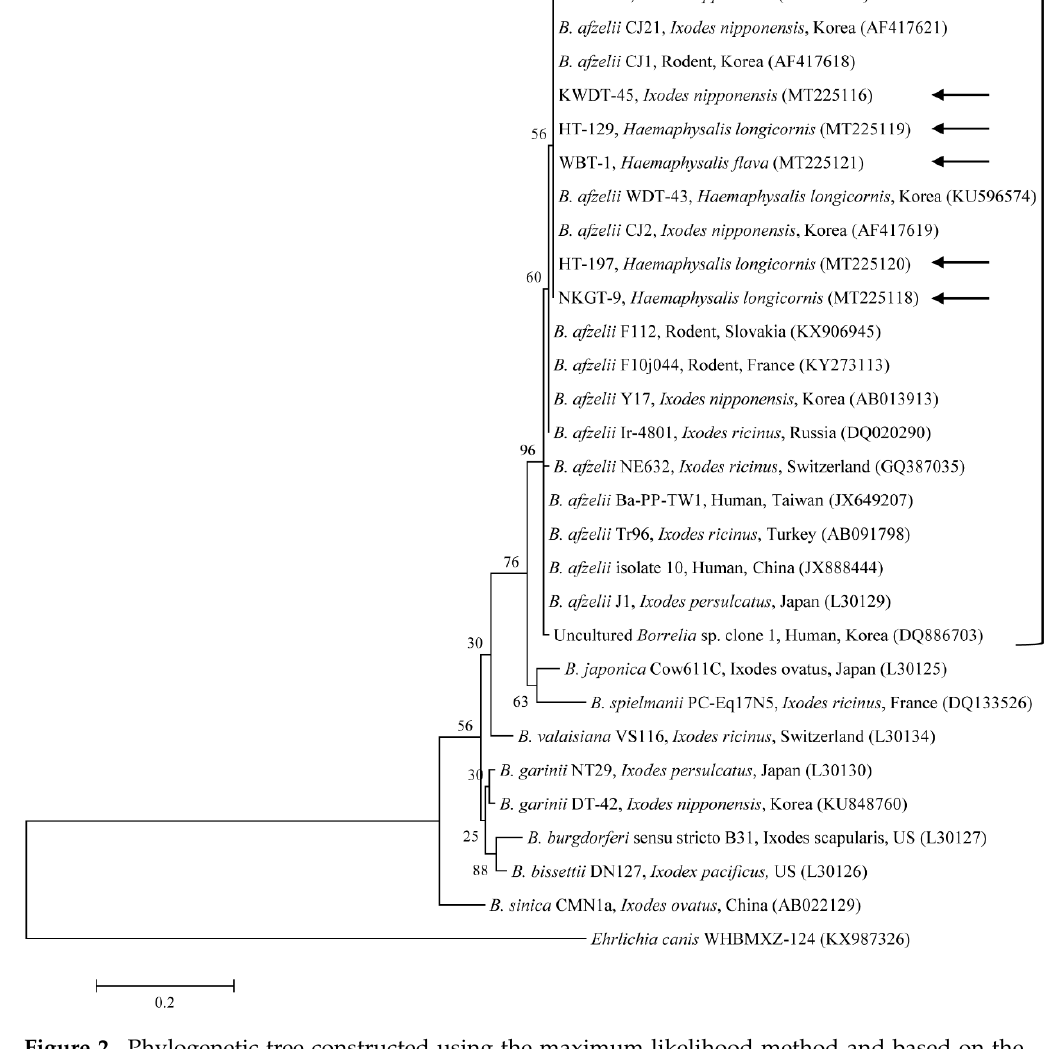
Figure 2. Phylogenetic tree constructed using the maximum likelihood method and based on the 5S–23S rRNA nucleotide sequences of Borrelia spp. Ehrlichia canis was used as the outgroup. Black arrows indicate the sequences analyzed in this study. B. afzelii , B. bissettii , B. burgdorferi s.s., B. garinii , B. spielmanii , and B. valaisiana infect humans with pathogenic potential, causing Lyme borreliosis. B. japonica and B. sinica have not yet been reported in or isolated from humans. GenBank accession numbers for other sequences are shown with the sequence name. Branch numbers indicate bootstrap support (1000 replicates). The scale bar indicates the number of substitutions per nucleotide.